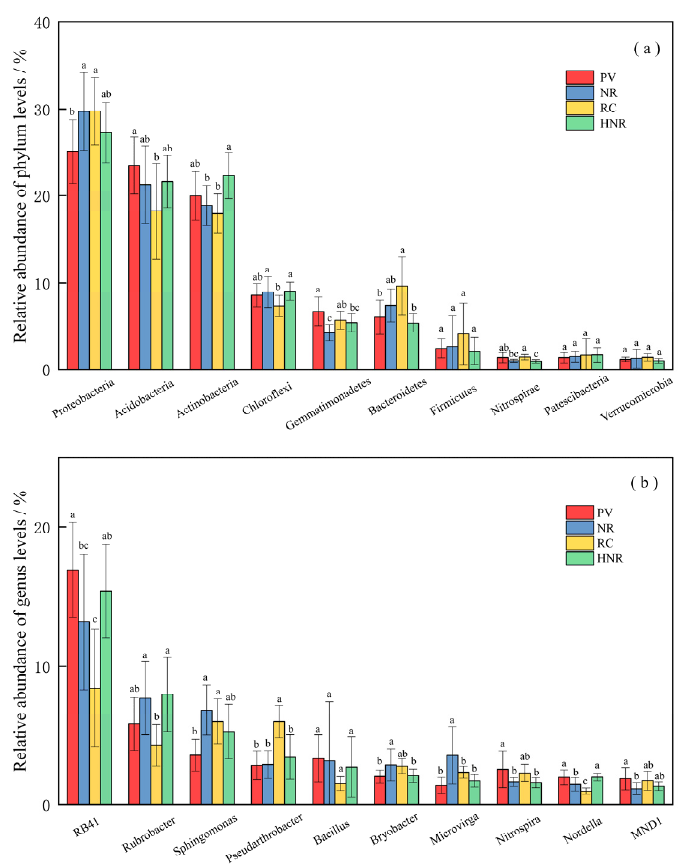
Figure 5. Histogram of community composition structure at the phylum level ( a ) and genus level level ( b ) in the study area. The different letters indicate significant at p < ( b ) in the study area. The different letters indicate significant at p < 0.05.